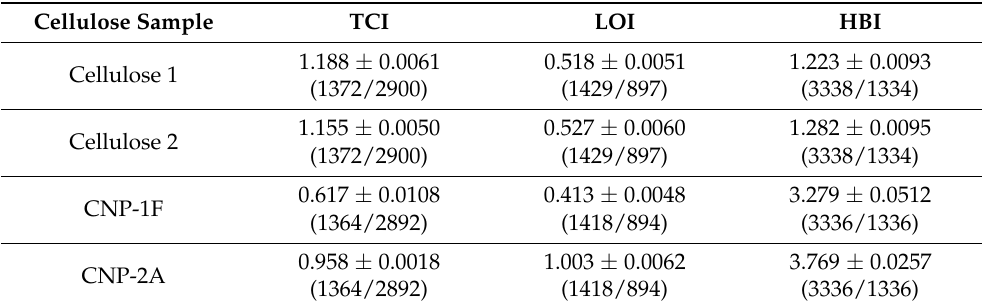
Table 3. Comparison of crystallinity indices and hydrogen bond intensity for CNP-1F, CNP-2A, Cellulose 1 and Cellulose